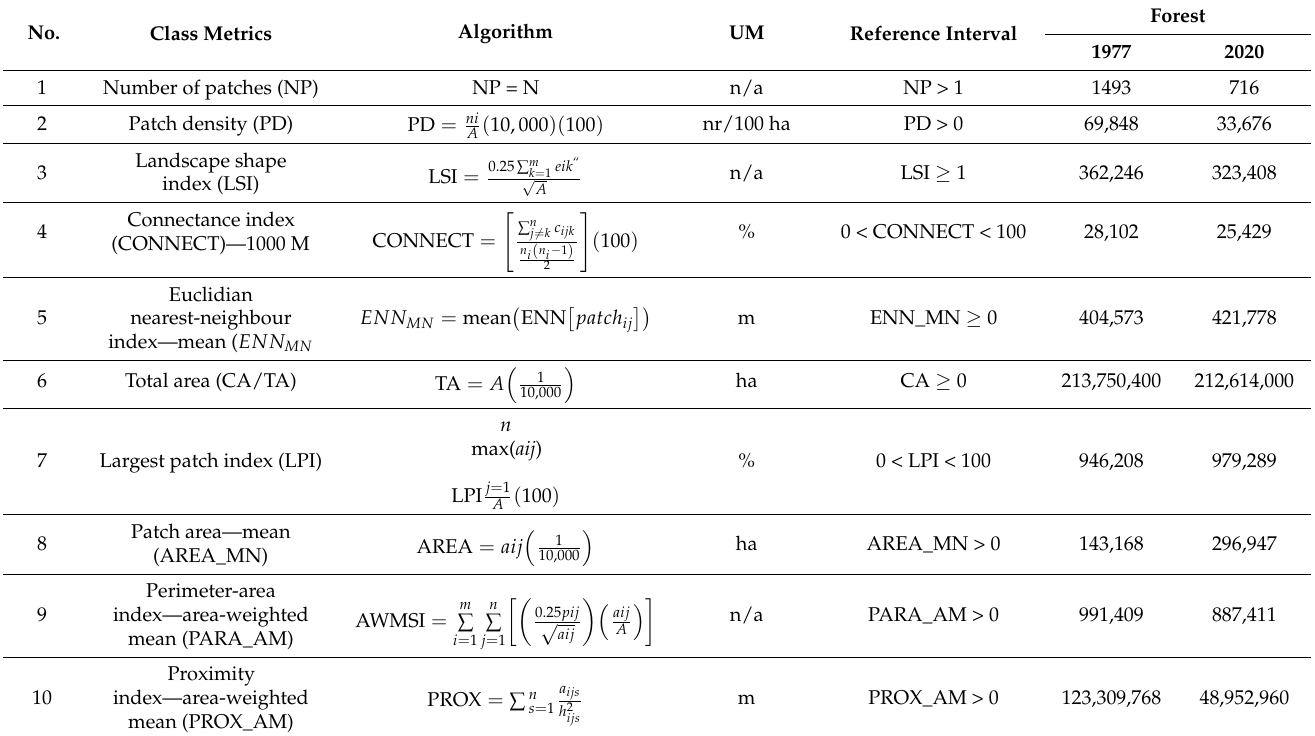
Table 4. Evolution of forest habitat fragmentation in the Bucegi Natural Park, 1977–2020, based on KH-9 imagery and Sentinel 2-MSI classification-derived